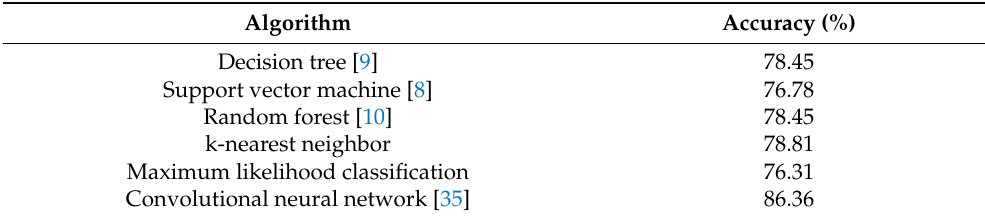
Table 18. Comparison of the model’s accuracy in this study with previous